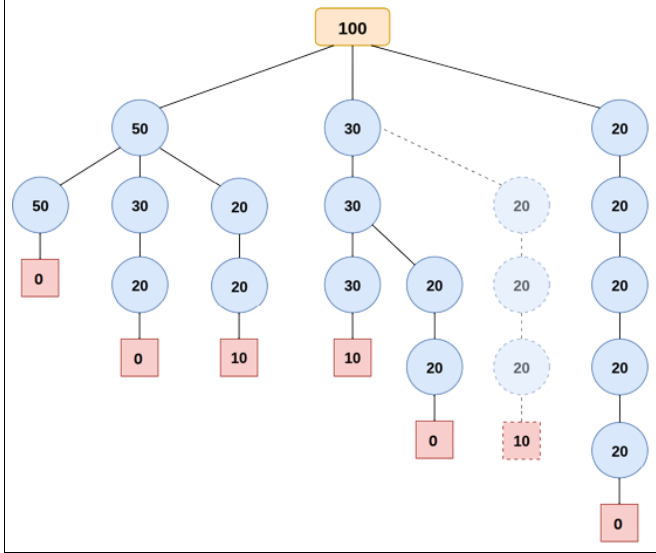
Figure 2. Example of a cutting pattern search tree.